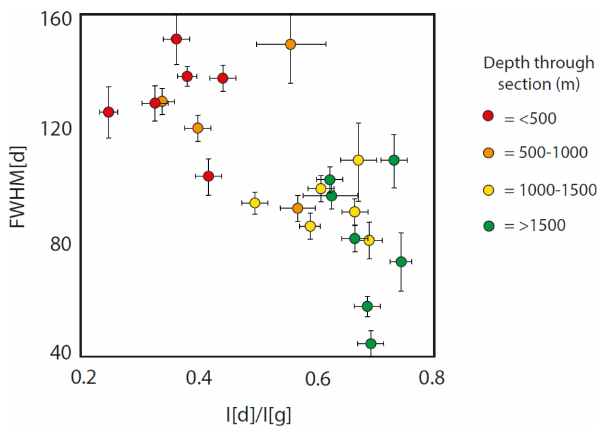
Figure 7. D-peak width (FWHM[d]) plotted against intensity ratio ( I D / I G ), with points coloured by depth through the overall